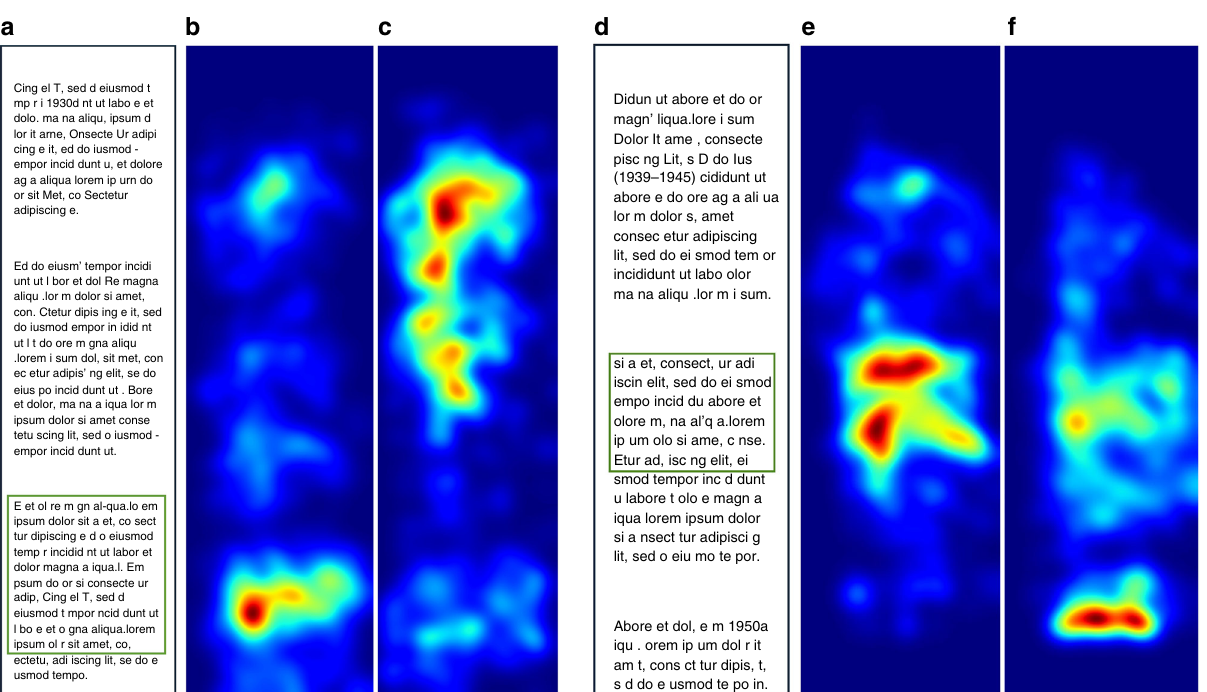
Fig. 8 Different gaze patterns for factual vs. interpretive tasks. a Sample passage shown to the participant (actual text replaced with dummy for copyright reasons). Green bounding box highlights the relevant excerpt for the factual task (box shown for visualization purposes only, participants did not see this). b Population-level gaze heatmap for the factual task, for the passage shown in ( a ). c Heatmap for the interpretive task for the passage shown in ( a ). d – f Similar to ( a – c ) except that the factual task appeared after the interpretive task. In both examples, gaze was more dispersed across the passage for interpretive than factual